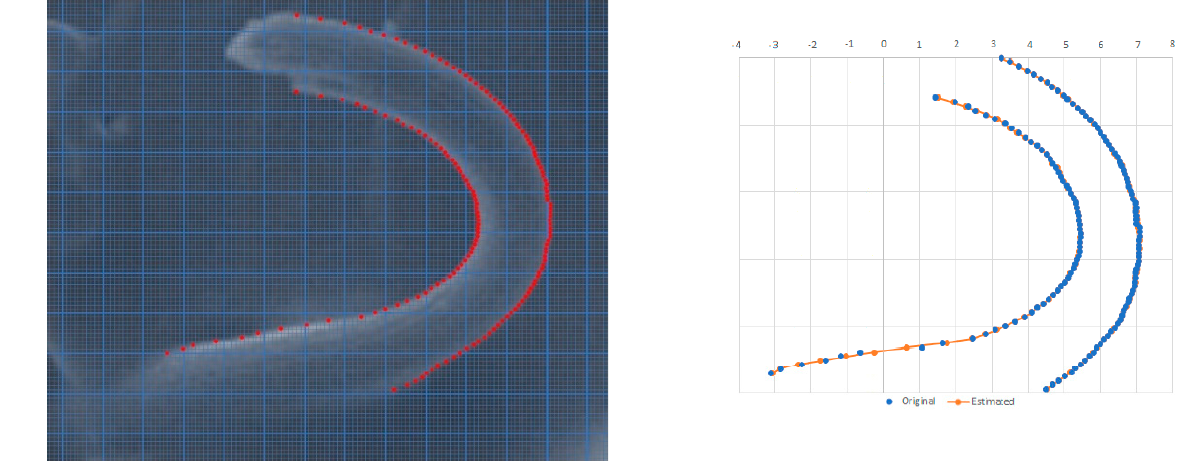
Figure 4. FESEM image of glass fibers–epoxy–PS fibers hybrid composite.